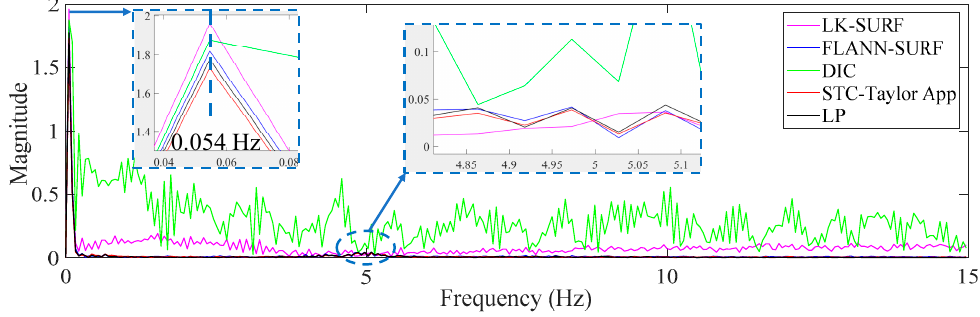
Figure 22. Displacement comparison in frequency domain of Case 3 (fog interference).